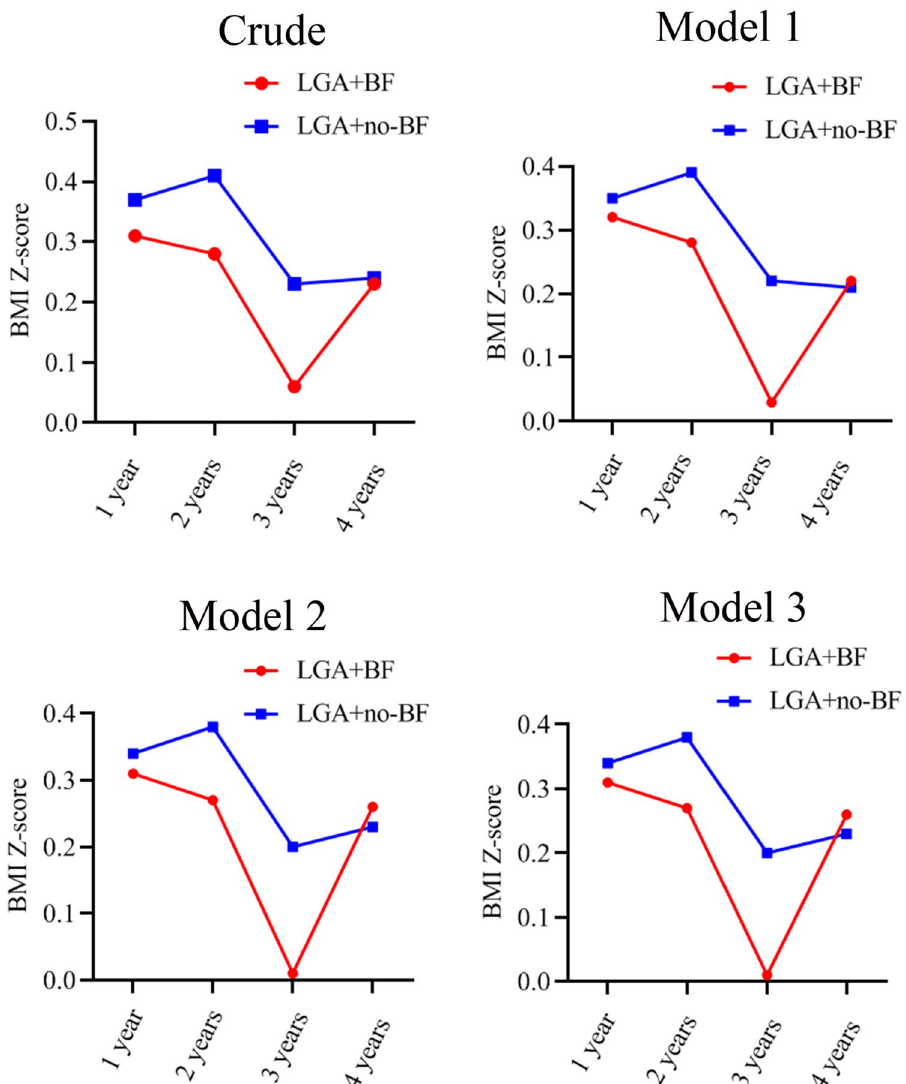
Figure 1. BMI Z-score trajectories of children were LGA-BF and LGA-no-BF from 1 to 4 years in different models. LGA large-for-gestation age, BMI body mass index, BF breast-feeding. Model 1, adjusted for maternal pre-pregnancy BMI; Model 2, adjusted for covariates in Model 1 + maternal age, education, and child sex; Model 3, adjusted for covariates in Model 2 + gestational diabetes melitus.